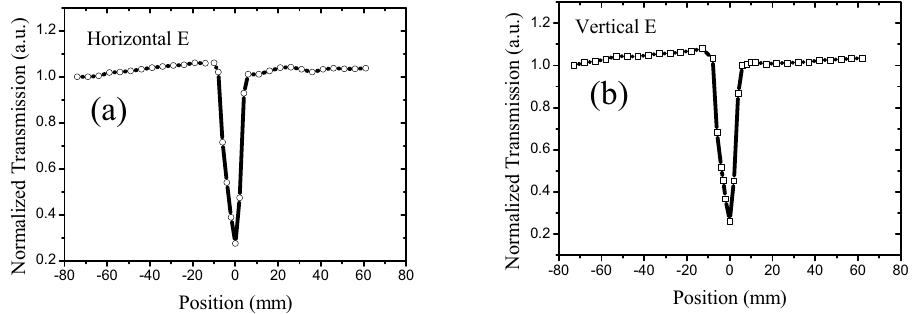
Figure 2. Z-scan results of graphene suspended in DI water. 527-nm laser with 100 mW power; transmission of grapheme suspension is 10%; cuvette is 10 mm wide.